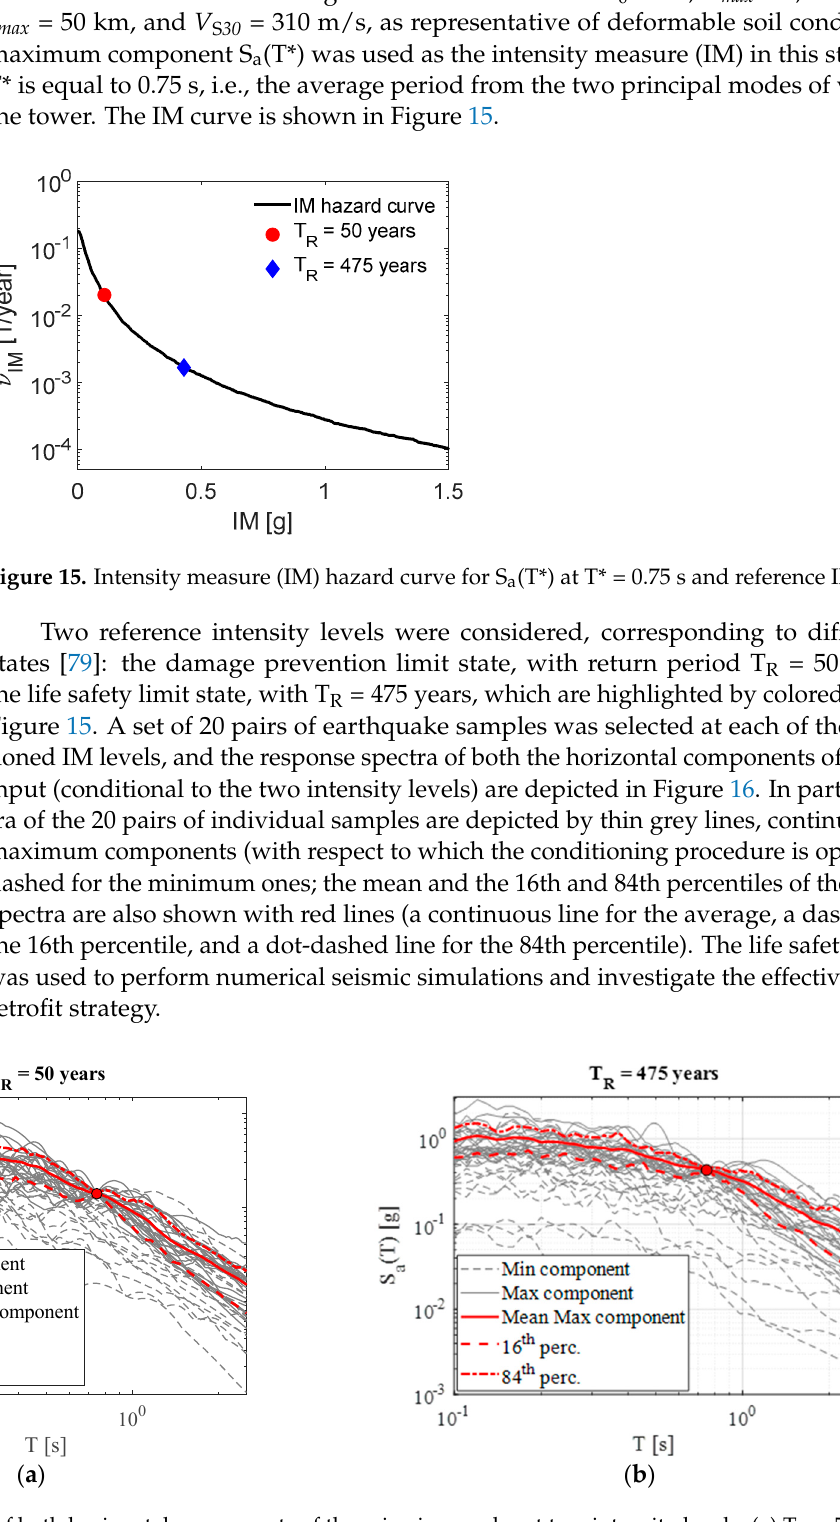
Figure 16. Response spectra of both horizontal components of the seismic samples at two intensity levels: ( a ) T R = 50 years and ( b ) T R = 475 years.